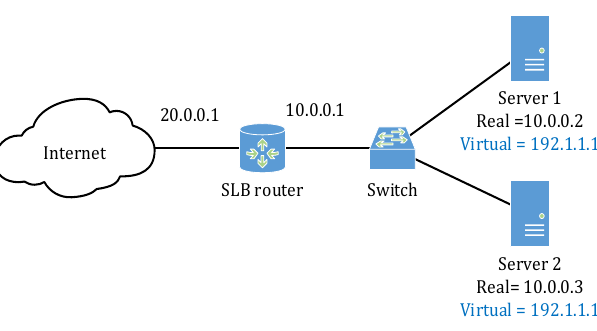
Figure 3. SLB router in dispatched mode (redrawn from [23])